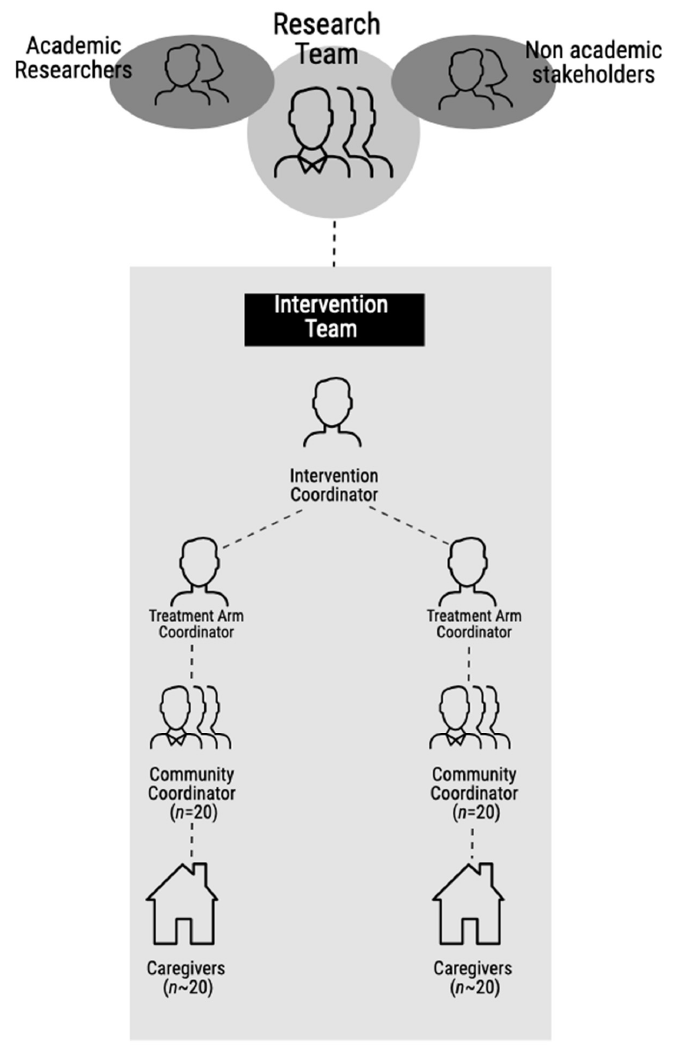
Figure 1. Outline of the Hygienic Family intervention implementation